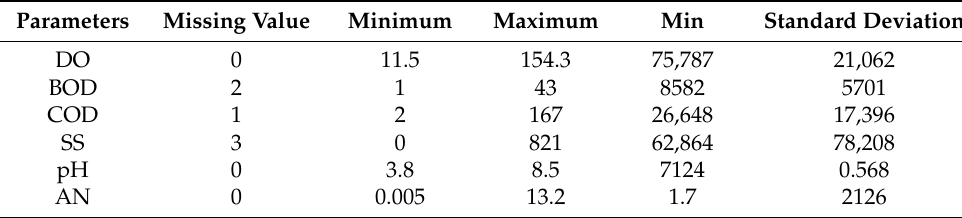
Table 2. Descriptive statistics of water quality